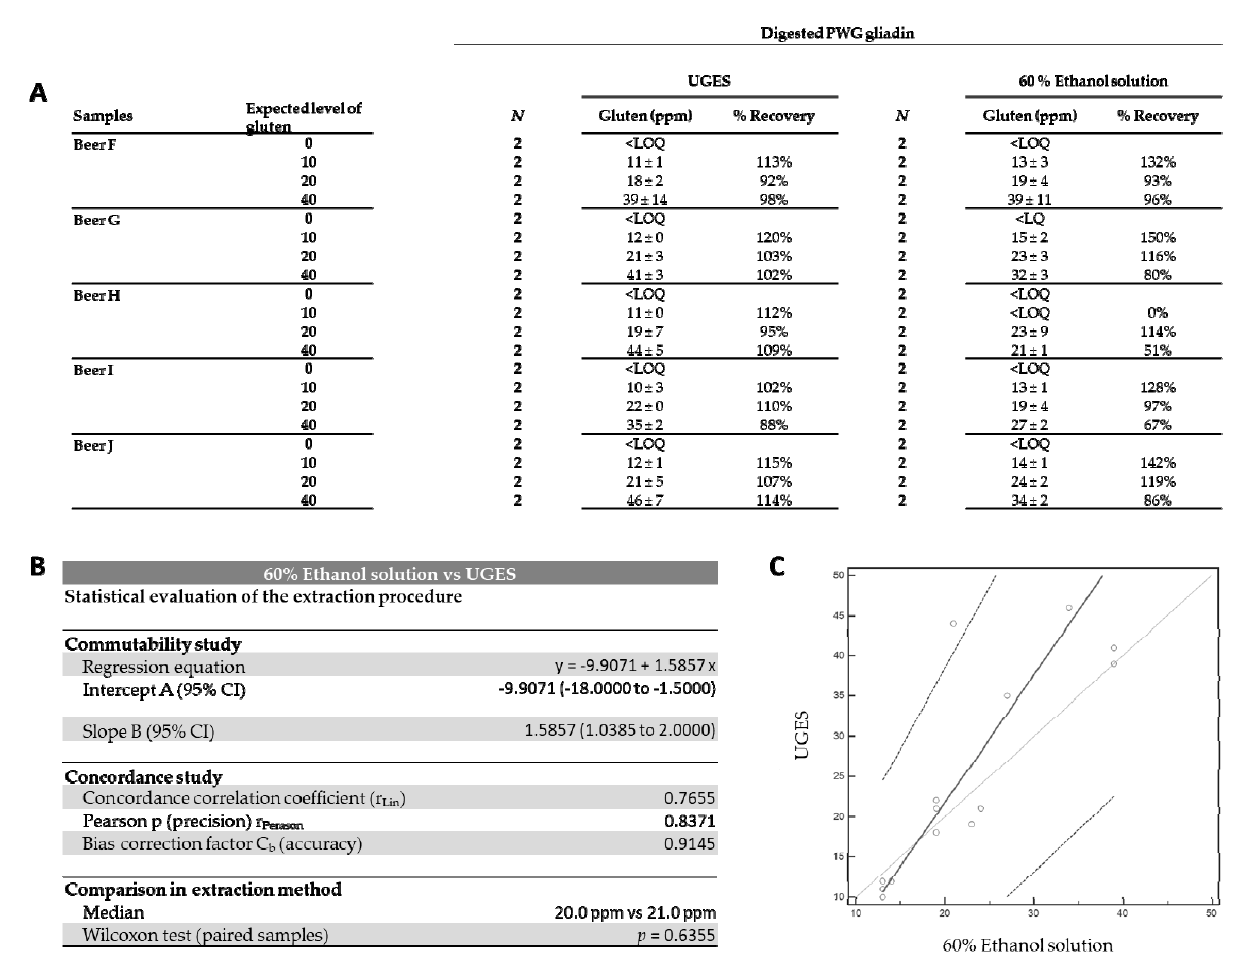
Figure 4. Analysis of spiked samples by competitive ELISA after extraction with Universal Gluten Extraction Solution (UGES) and 60% ethanol solutions. ( A ) Recovery of the different levels of gluten provided in the food samples. Results are expressed as ppm of gluten (mean ± SD) and percentage of gliadin recovery (R). N = number of analyses. ( B ) Statistical evaluation of the extraction procedure. ( C ) Scatter diagram with regression line and concordance bands for regression line. <LOQ, less than the limit of quantification; PWG, Prolamin Working Group.